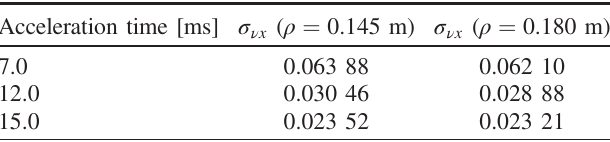
TABLE IV. Calculated rms spread of horizontal betatron tune σ ν x by changing the radius of the vacuum chamber. The tune spread is reduced as ρ is increased, but the beam tends to be more unstable with an increasing ρ (Fig. 16).